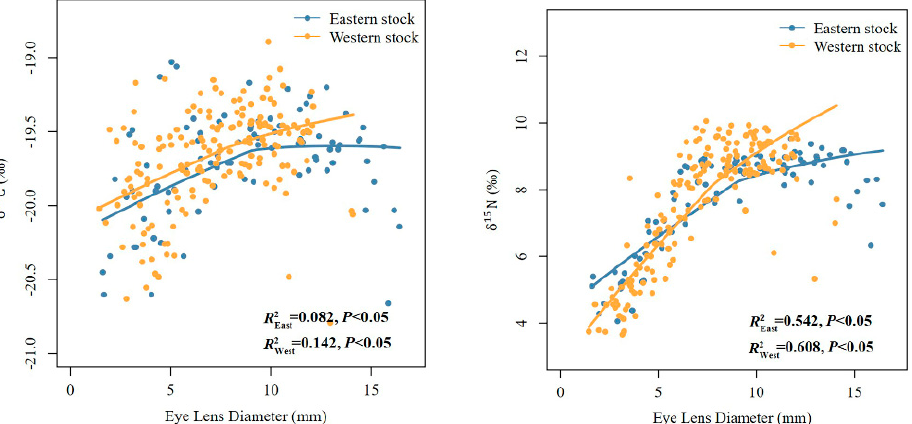
Figure 8. Relationship between the eye lens stable isotope values and LD. The blue and yellow lines represent loess curves across all individuals in the eastern and western stocks, respectively and illustrate the overall population trends.